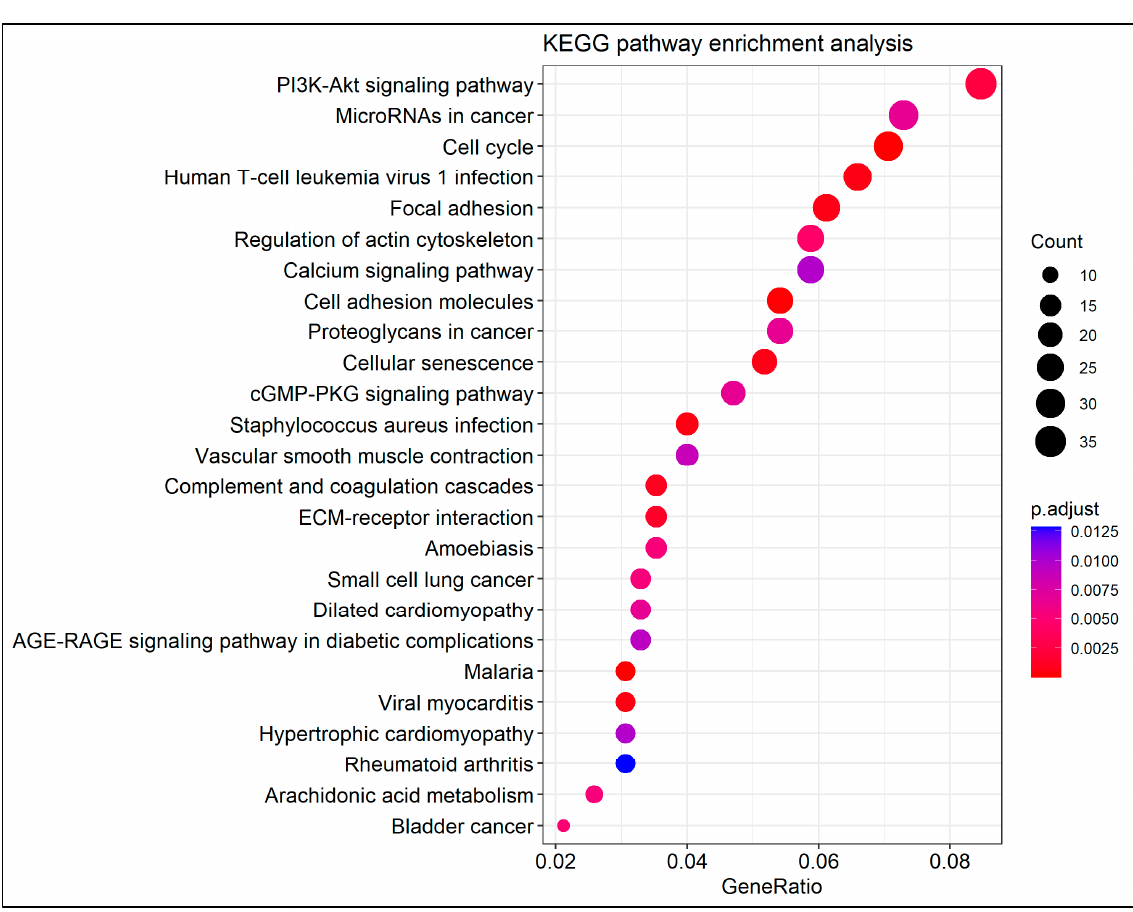
Figure 5. Top 25 significant terms of the KEGG pathway analysis.